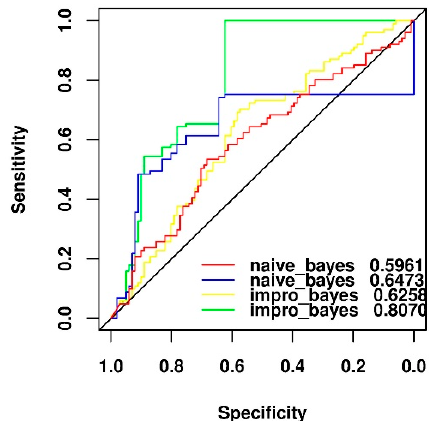
Figure 4. Performance comparison of two different feature selection algorithms for the N2 negative data set by using the naïve Bayesian and improved naïve Bayesian method of the leave-one-out cross validation test. The blue and green lines used our new method to select features, while the red and yellow lines used the mRMR algorithm for feature selection.